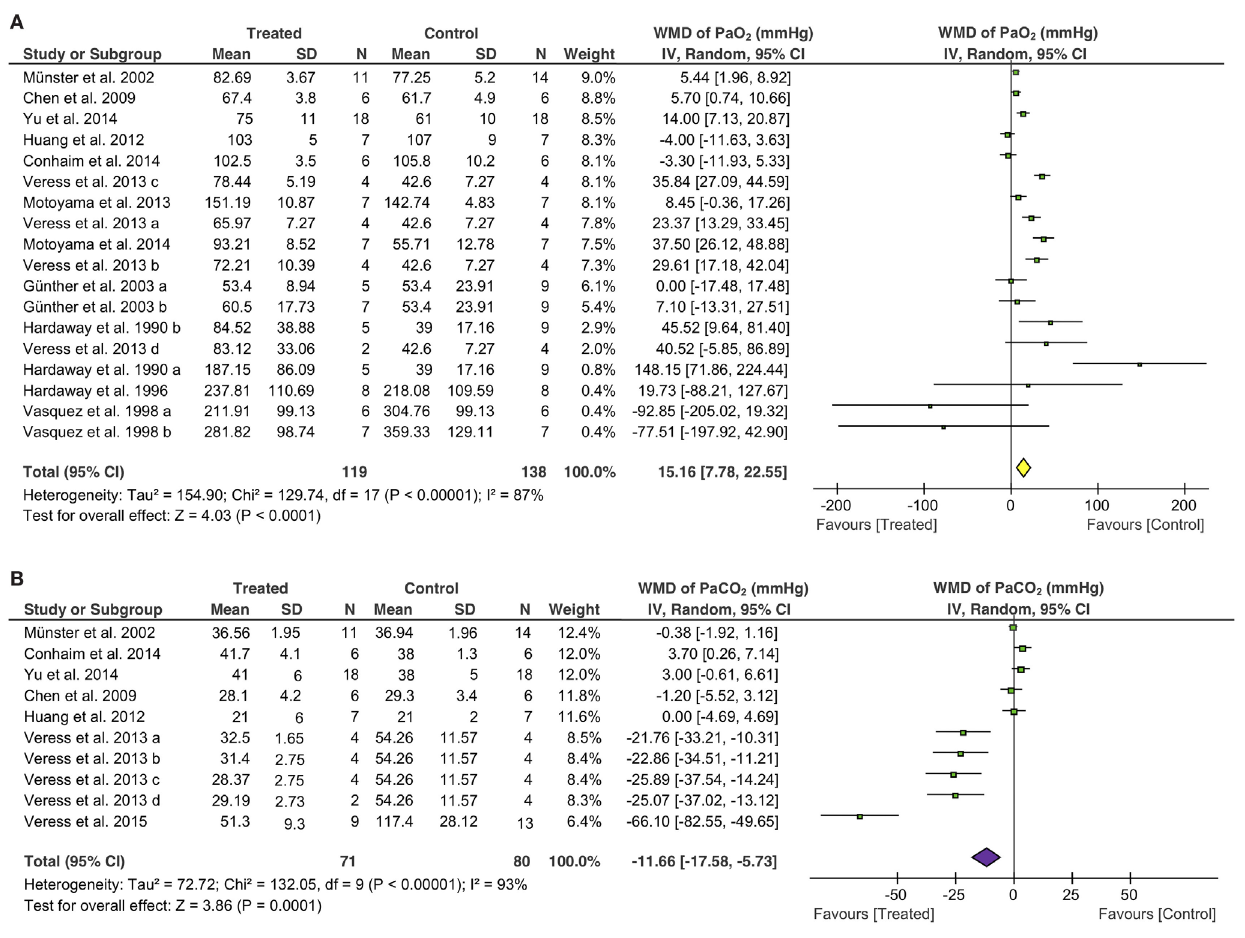
FiGURe 3 | Effect of fibrinolytic therapy on PaO 2 (a) and PaCO 2 (B) . Weighted mean difference (WMD, square) and overall effect (diamond) are